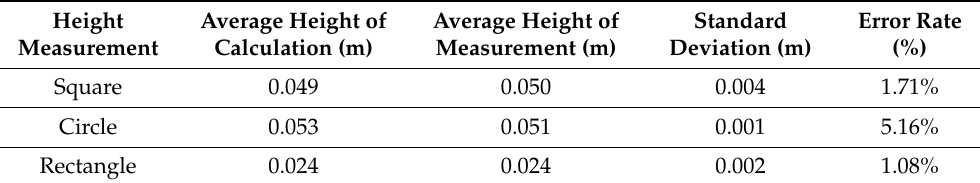
Table 3. Height measurement of target